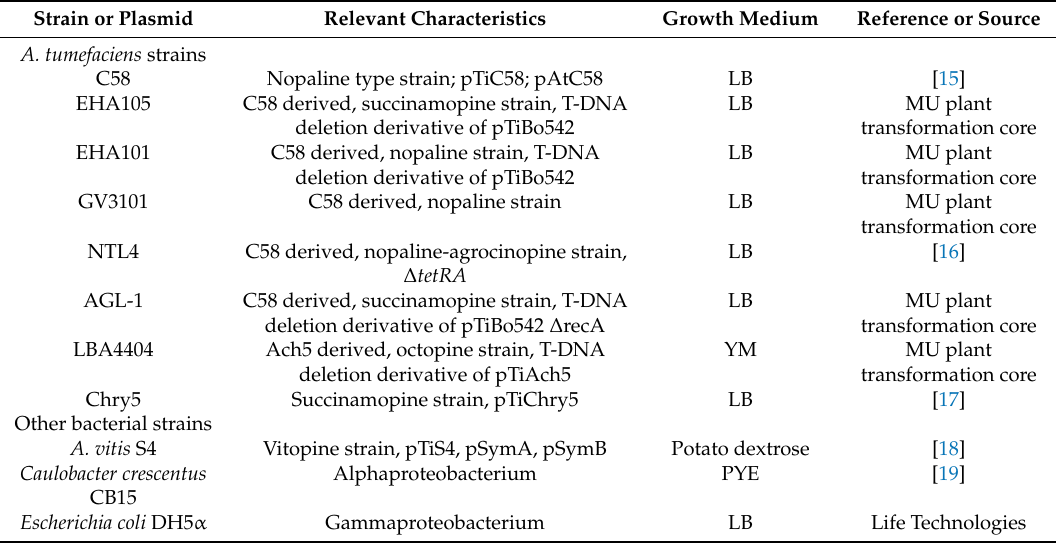
Table 1. Bacterial strains used in this